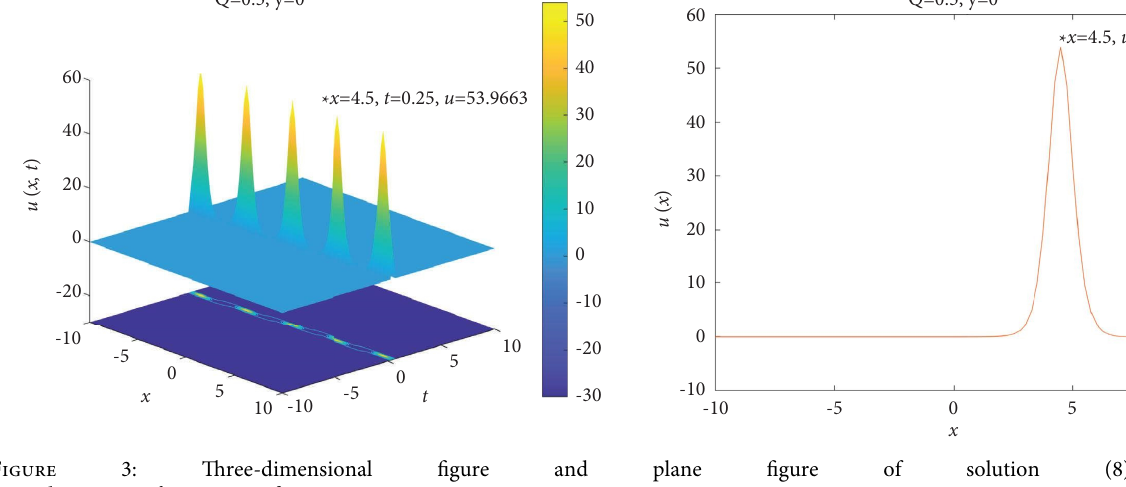
3: Tree-dimensional